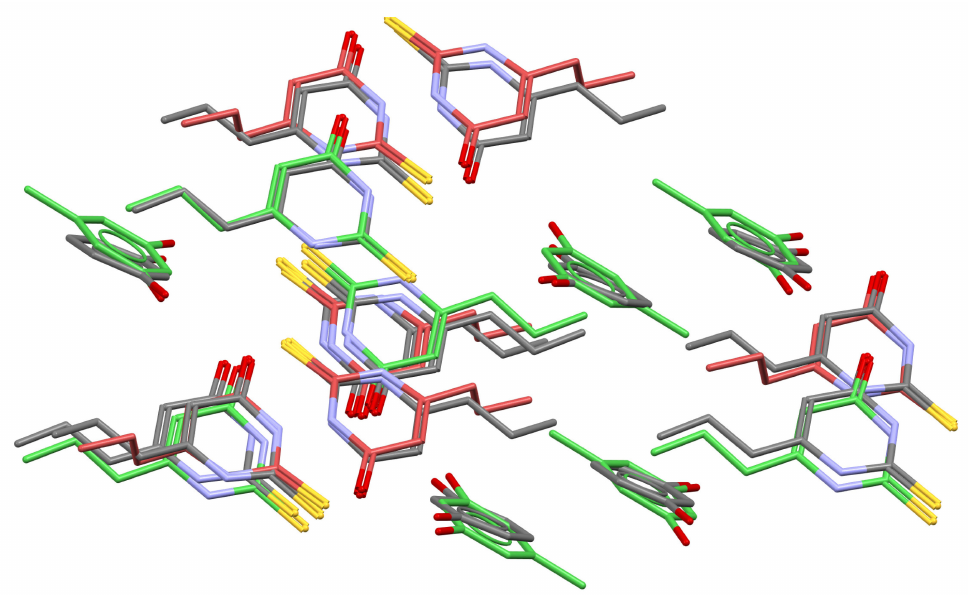
Figure 7. Crystal packing similarity plot comparing the PTU–RES and PTU–ORC crystal struc- tures. Green: matching molecules. Red: not matching molecules due to different conformation of PTU molecules.